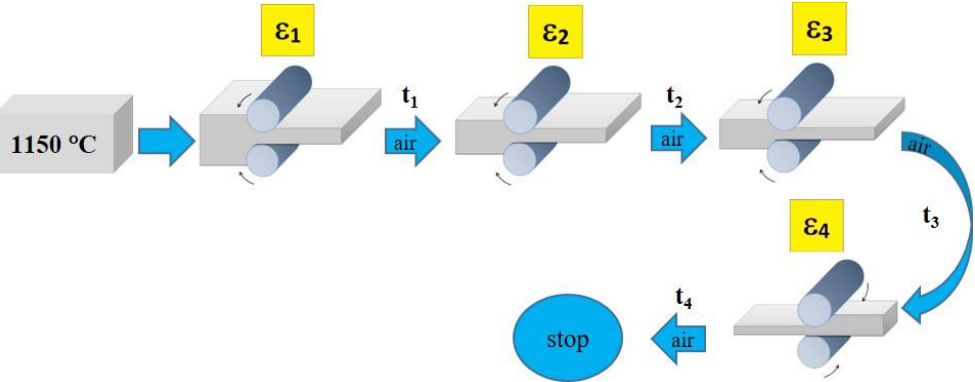
Figure 18. Flat rolling scheme. Table 1. Simulation parameters.